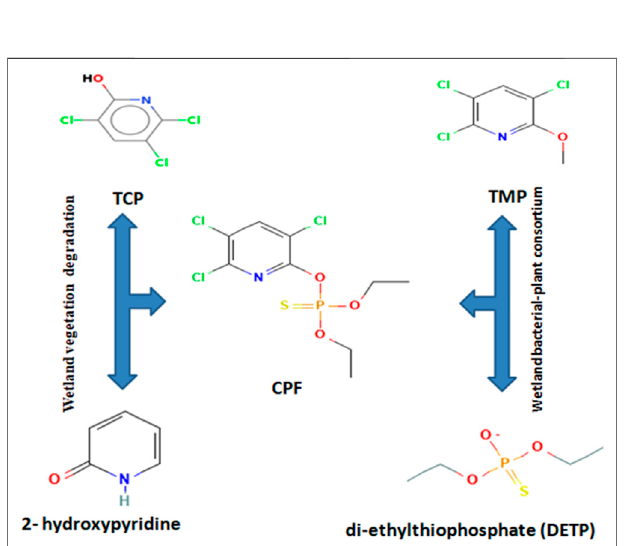
FIGURE 3 | GC chromatogram of the chlorpyrifos metabolites formed in the microbial – plant consortium.